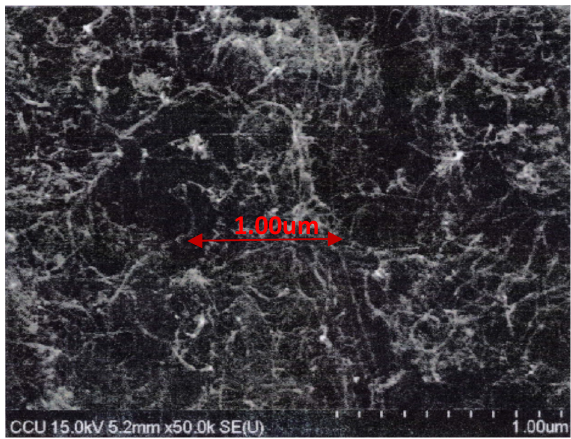
Fig.1. TEM image of